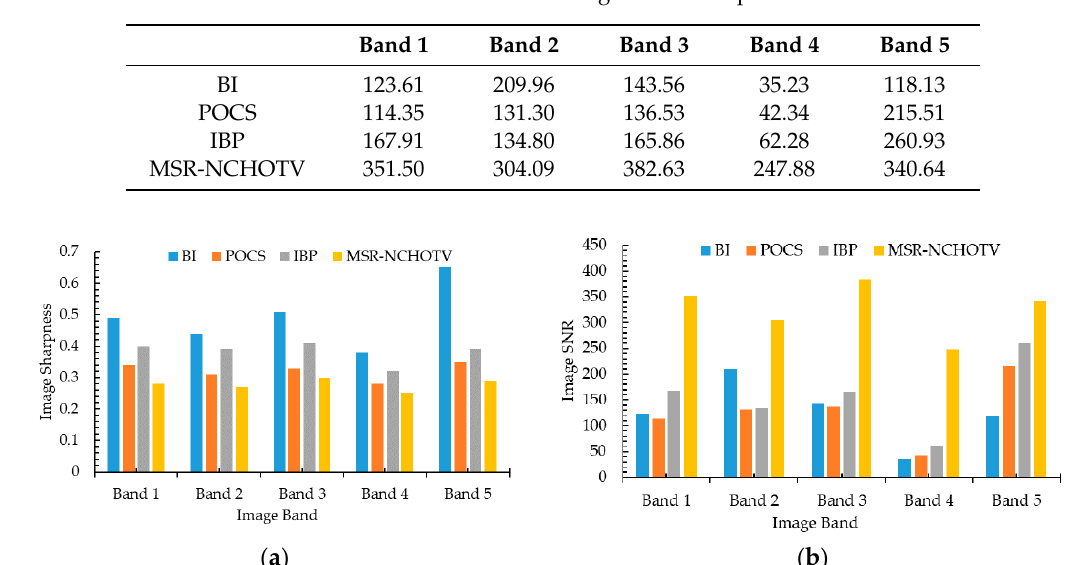
Figure 9. Image sharpness ( a ) and SNR ( b ) for Experiment 2.